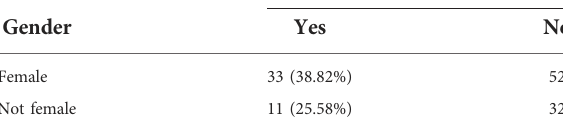
TABLE 4 Contingency table for WHO-5 increments (in the original data), split by gender values.